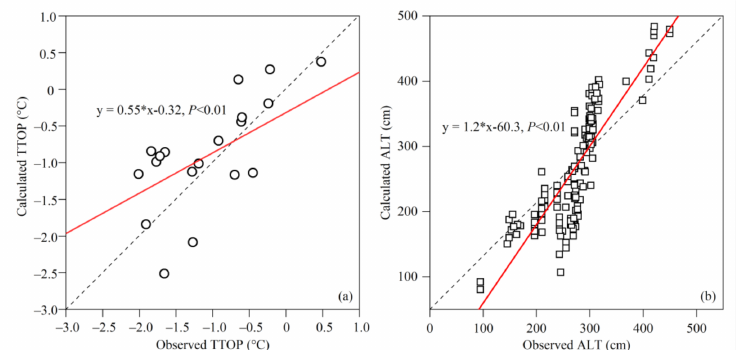
Figure 2. Comparisons of calculated temperature at the top of the permafrost or the bottom of the maximum frozen soil depth (MFSD) (TTOP) and measured TTOP ( a ), as well as calculated active layer thickness (ALT) and measured ALT ( b ), in the Qilian Mountains. Red line and dashed line demonstrate the linear trend and 1:1, respectively.